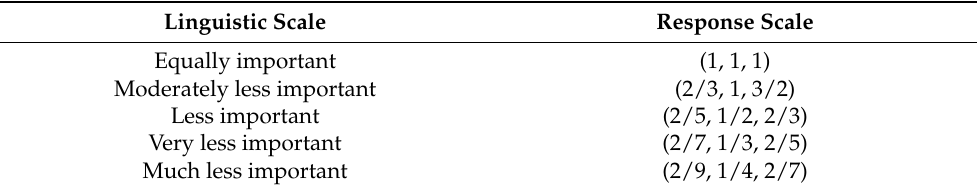
Table 2. Inadequate scale used by the authors in [35] in fuzzy SWARA. Linguistic Scale